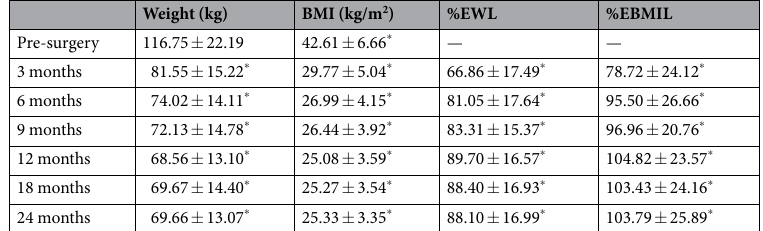
Table 2. Post-OAGB weight loss evolution over 24 months, expressed in kg, BMI, %EWL and %EBMIL. The values are expressed as mean ± standard deviation. * P < 0.001 compared with pre-surgical control. No patients (N = 100) were lost to follow-up. BMI = body mass index; %EWL = percent excess weight loss; %EBMIL = percent excess BMI.